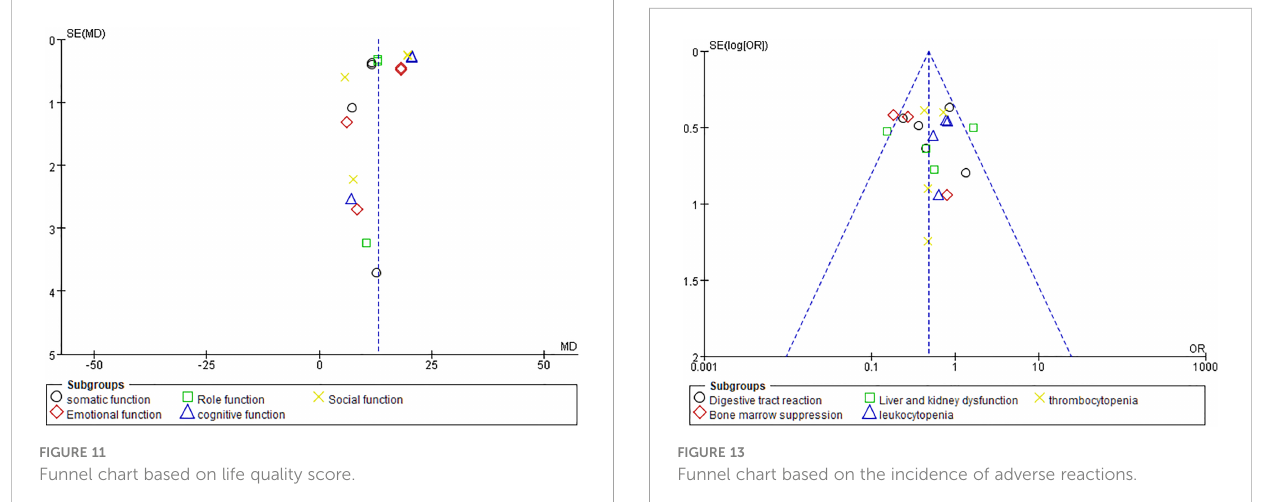
FIGURE 13 Funnel chart based on the incidence of adverse